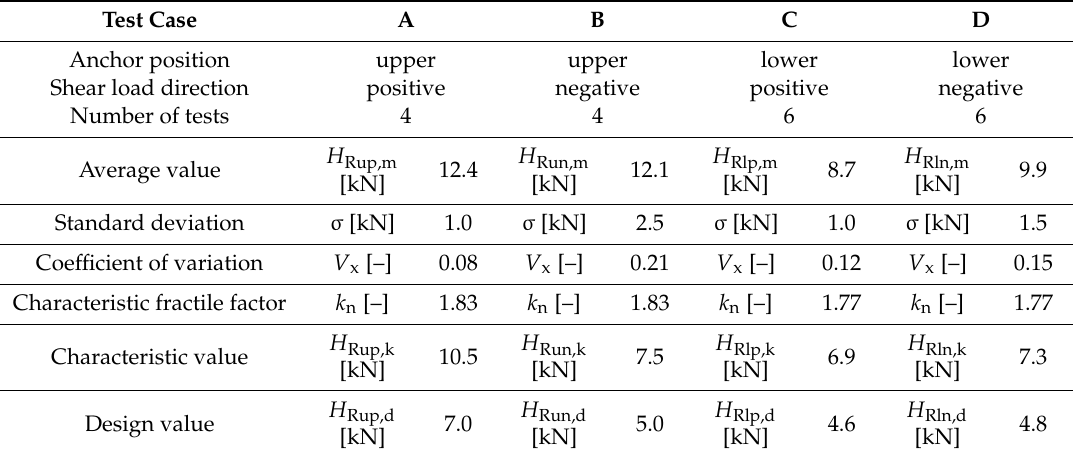
Table 4. Summary of anchor shear load capacity for the four load